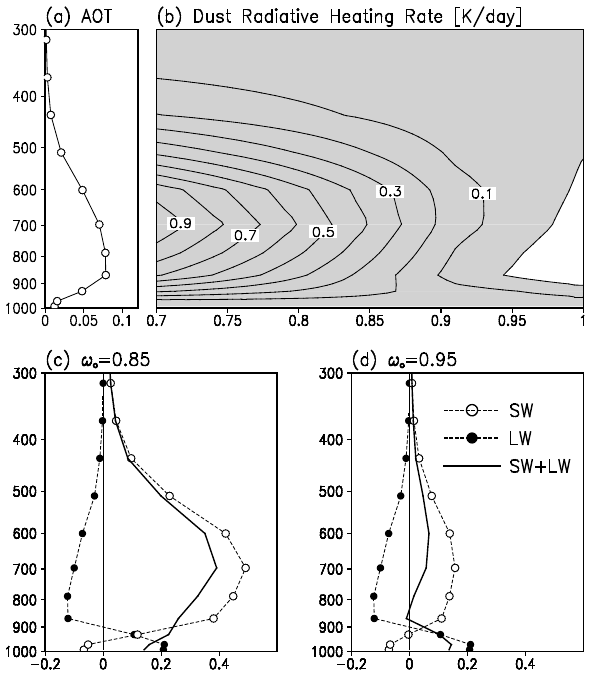
Fig. 9. Vertical profile of (a) Saharan dust layer off coast of W. Africa from GOCART, (b) dust radiative heating as a func- Figure 9 Vertical profile of a) Saharan dust layer off coast of W. Africa from GOCART, b) dust tion of single scattering albedo, ω o for the same dust profile with AOD=0.35, (c) atmospheric heating due to SW and LW, and radiative heating as a function of single scattering albedo, (cid:127) SW+LW for ω o =0.85, and (d) atmospheric heating due to SW and LW, and SW+LW for ω o with AOD=0.35, c) atmospheric heating due to SW and LW, and SW+LW for (cid:127) =0.85, and d) atmospheric heating due to SW and LW, and SW+LW for (cid:127) o